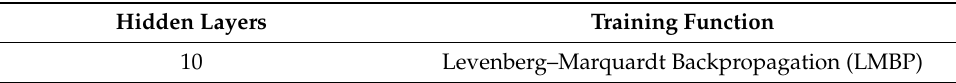
Table 5. Parameter characteristics used for MLP in this study.